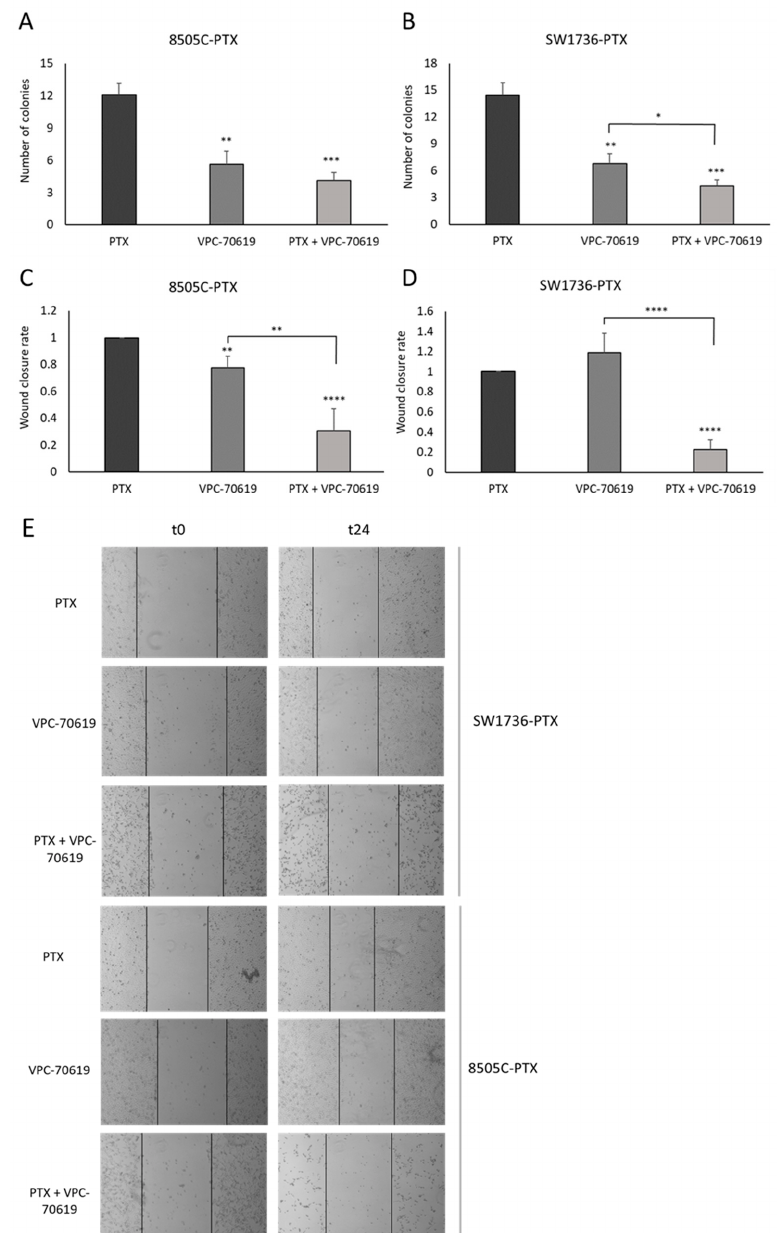
Figure 10. Effects of VPC-70619 treatment on the aggressive behavior of cancer cells. Panel ( A , B ): inhibitory effects of VPC-70619 on the ability to form colonies in an anchorage-independent way, which was studied by soft agar assay. The y-axis of each histogram shows the number of colonies formed for each condition (treatment with paclitaxel (PTX), VPC-70619 alone /VPC-70619) and combination (PTX + VPC-70619)). n = 3. Panels ( C , D ) show the change in cell migratory capacity after single and combined treatment, in both cell lines. Migratory capacity was evaluated by wound healing assay. The wound closure rate was calculated measuring the difference in wound width (WW) at time zero (t0) and after 6 h (t6). The formula used is as follows: Wound closure rate = ( WWt 0 − WWt 6) treatment ÷ ( WWt 0 − WWt 6) control . Panel ( E ): Photos showing wound mar- gins (continuous black lines) at the beginning of migration (t0) and after 6 h (t6). * p < 0.05, ** p < 0.01, *** p < 0.001, **** p <